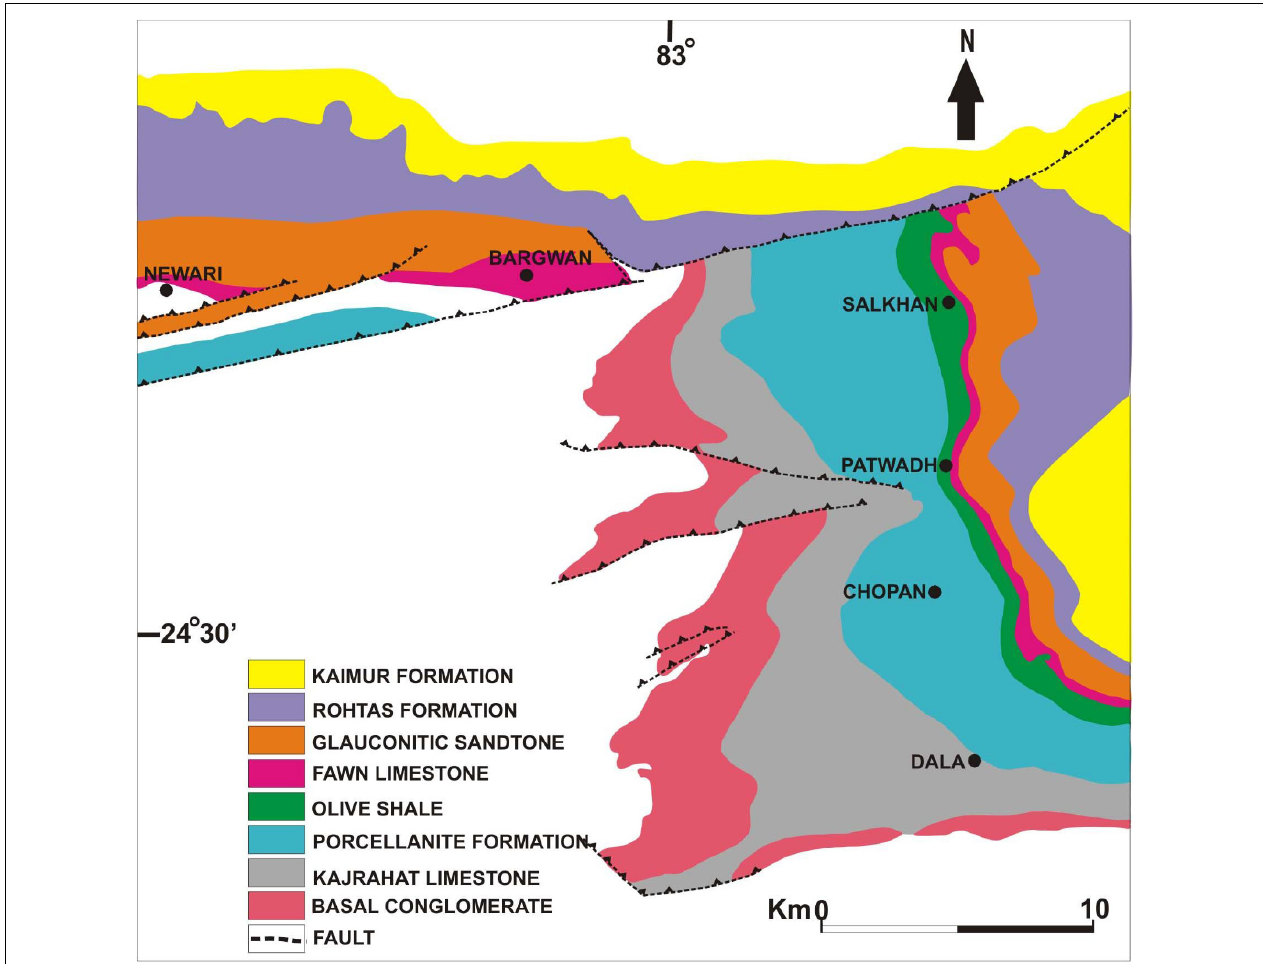
FIGURE 2 | Geological map showing lithostratigraphic units of the Son Valley Section (after Auden, 1933).